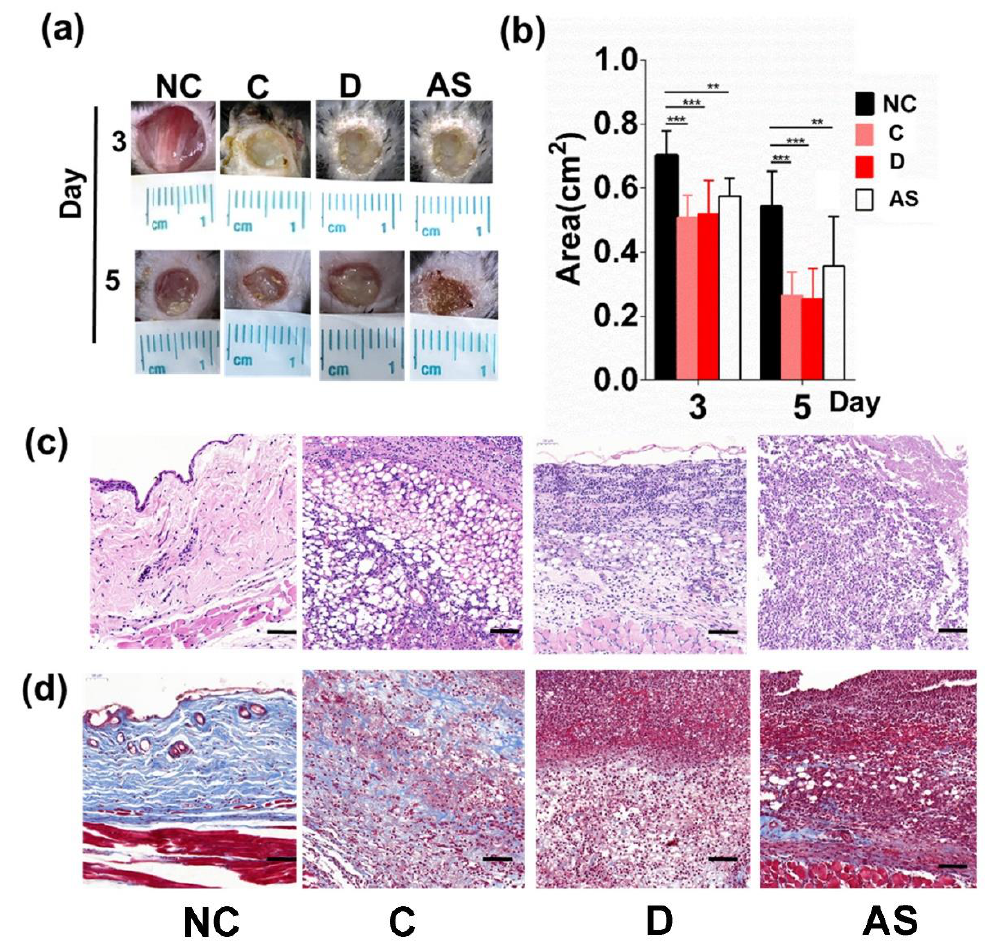
Figure 8. Monitoring the wound-healing process with the hydrogels on a full excision wound of diabetic mice during a 5-day period. ( a ) Digital images of diabetic wounds at Day 3, 5. ( b ) Qualification of the wound area in response to the wound therapies (right panel, n = 5) ( ** p < 0.01, *** p < 0.001). ( c ) Representative H&E staining of the wound tissues from each group (Day 5). ( d ) Representative staining of the wound tissues with Masson ’s trichrome method.